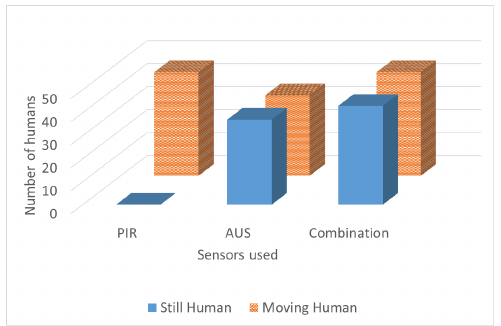
Figure 5. Number of human correctly classified (total number =